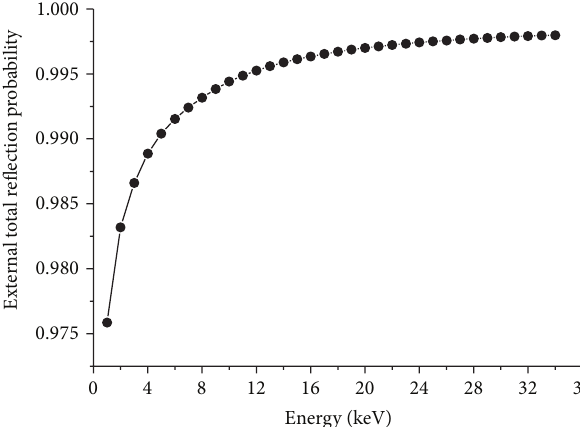
Figure 3: Probability of total reflection as function of energy, for photons at the third reflection with the largest incident angle in the total reflection regime. It was calculated through (4) taking 𝛿 = 2 and the incident angles at each reflection equal to the total reflection angle.